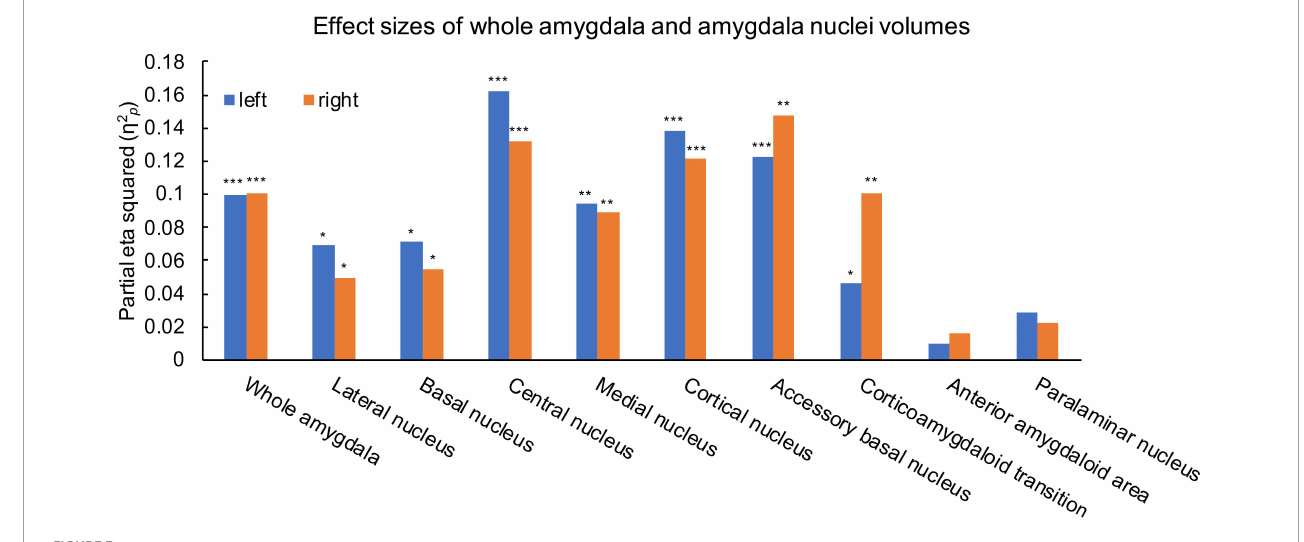
FIGURE3 Effects size estimates measured by partial eta squared ( η 2 p ) for the left (blue) and right (orange) whole amygdala and amygdala nuclei. η 2 p = 0.01 indicates a small effect; η 2 p = 0.06 indicates a medium effect, and η 2 p = 0.14 indicates a large effect. *** q < 0.001, ** q < 0.01, * q < 0.05.